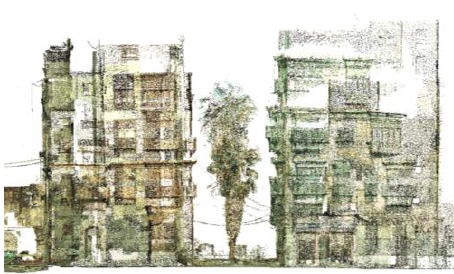
Figure 9. West Elevation from JHBIM.